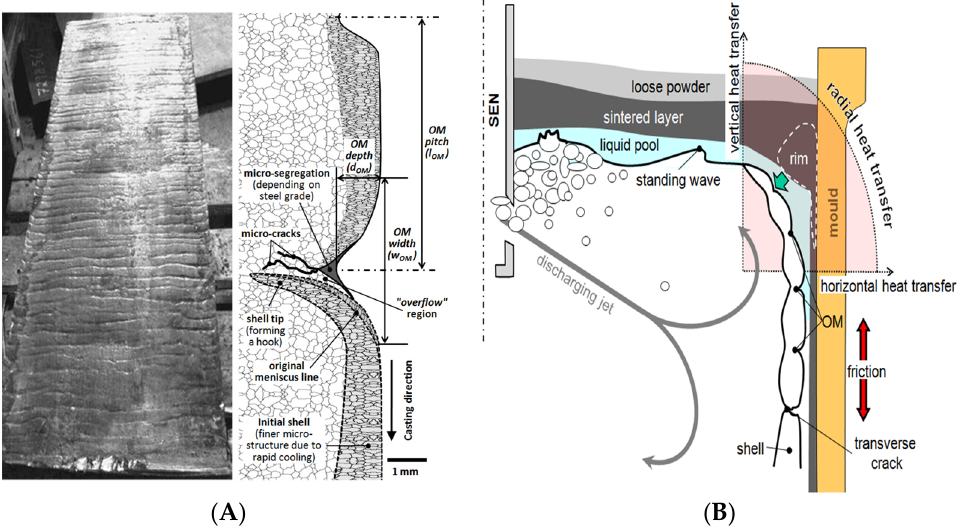
Figure 6. ( A ) Typical defect that can lead to oscillation marks on a cast slab in a continuous casting mold, together with a schematic diagram showing the cross-section around an oscillation mark. ( B ) represents the results of a Computational Fluid Dynamic (CFD) predicting how the initial steel shell is formed [12].